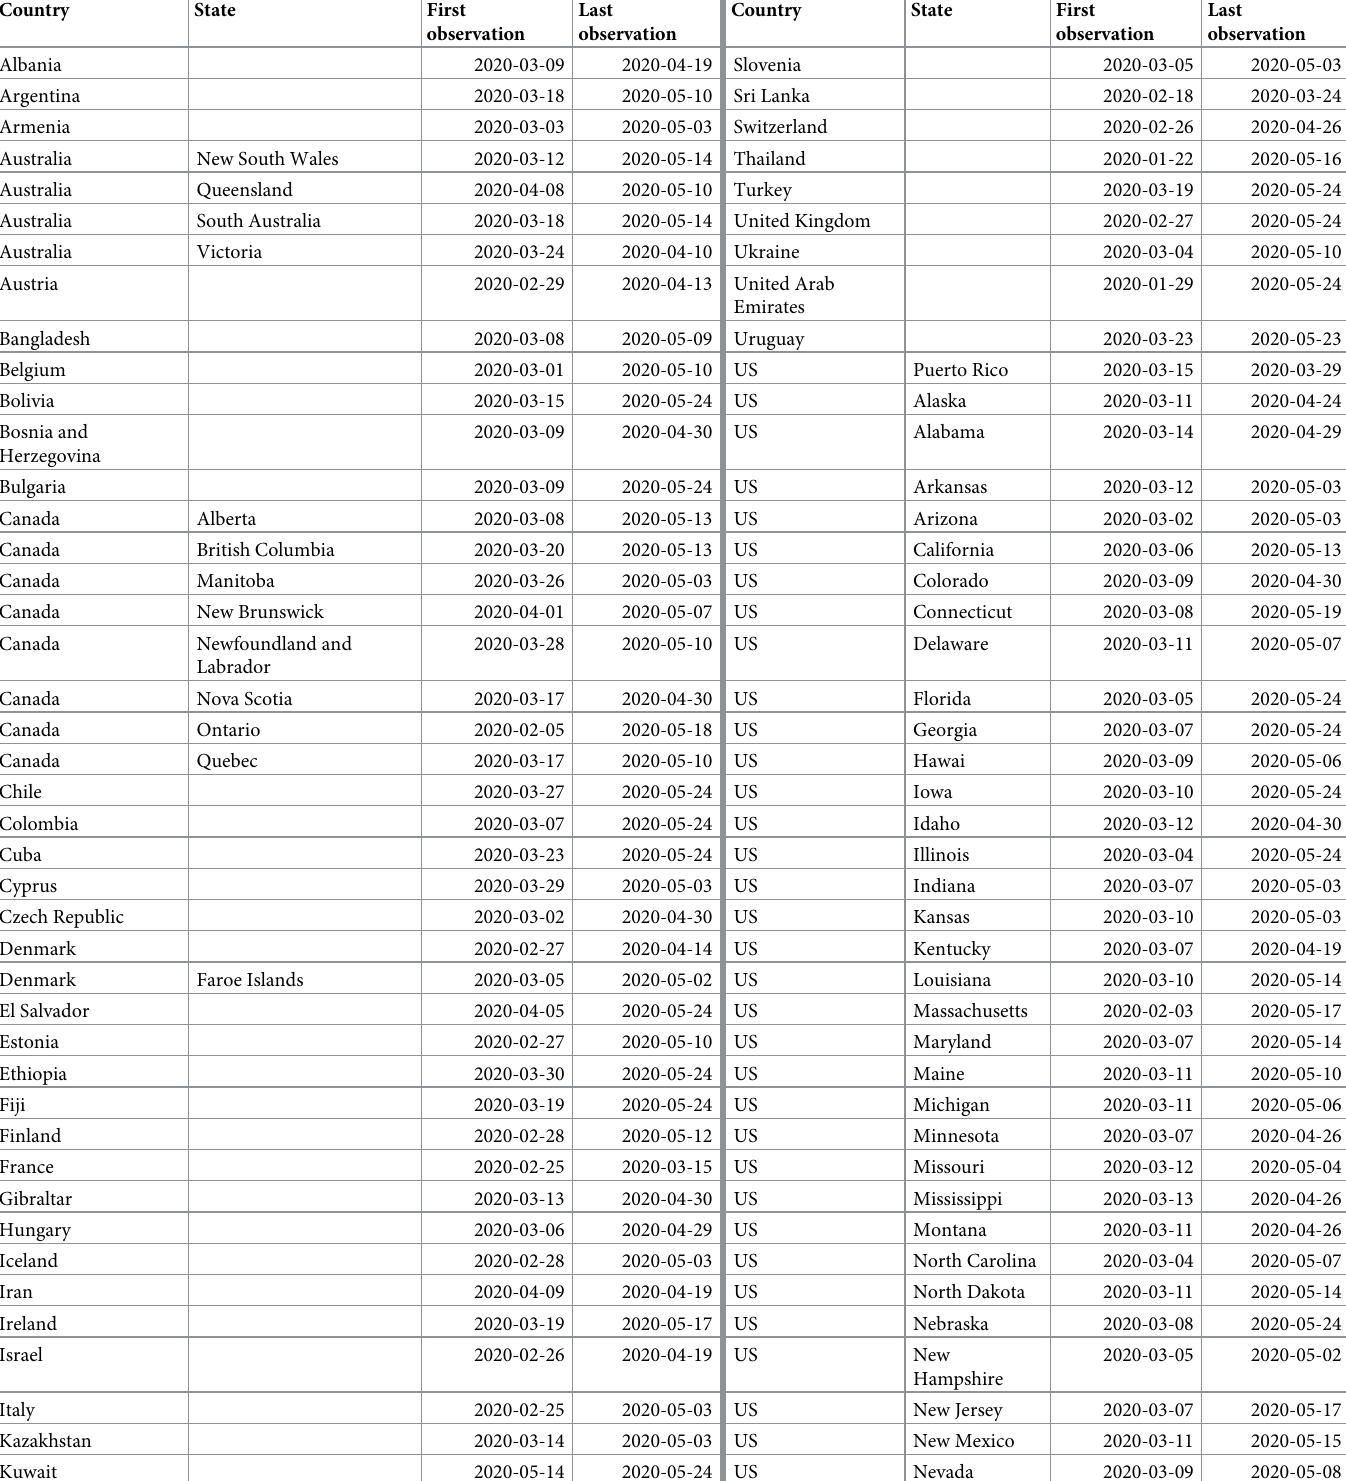
Table 1. Countries and states and their observed